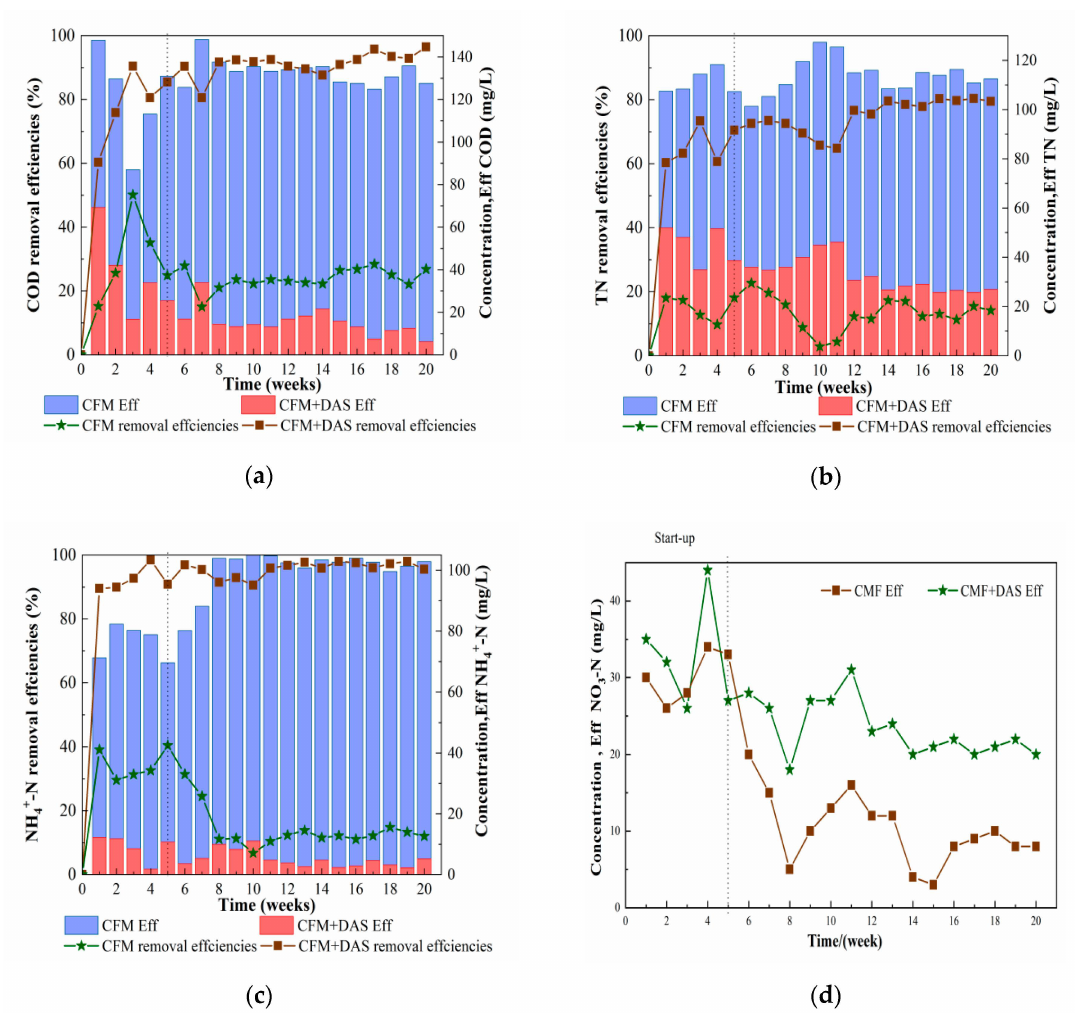
Figure 2. Mean concentration of the e ffl uent and COD, total nitrogen (TN), and NH 4 + -N removal e ffi ciencies using the CFM-DAS biofilter over time. ( a ) Removal of chemical oxygen demand (COD). ( b ) Removal of total nitrogen (TN). ( c ) Removal of ammonium nitrogen (NH 4 + -N). ( d ) E ffl uent of nitrate nitrogen concentration (NO 3 −